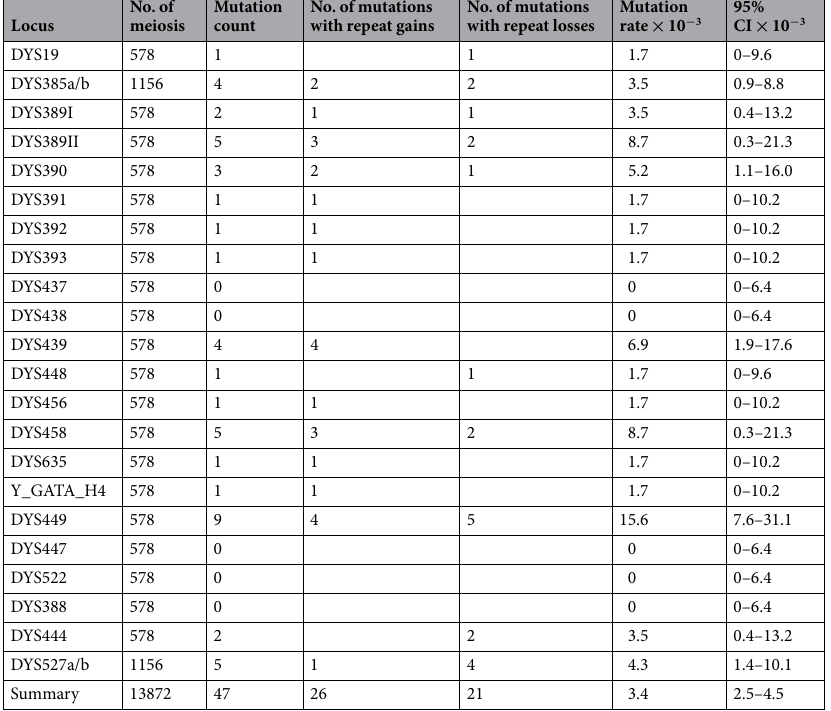
Table 2. The mutation and rates for the 22 Y-STR loci studied in Northern Chinese